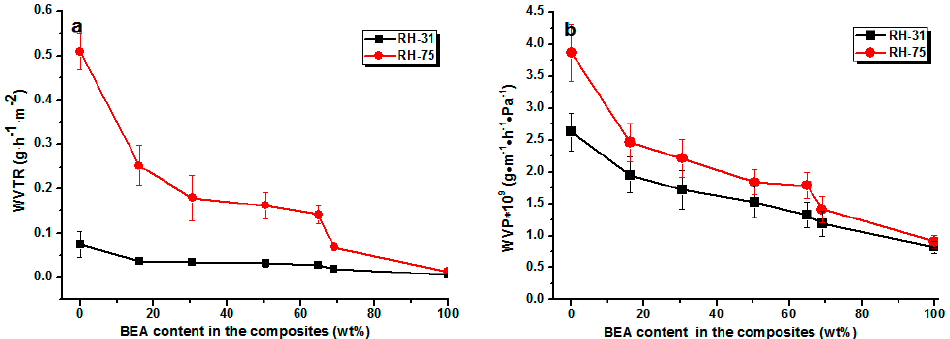
Figure 7. Water vapor transmission rate (WVTR) ( a ) and water vapor permeability (WVP) values ( b ) of the composite films with a different content of loaded resin at a different relative humidity.